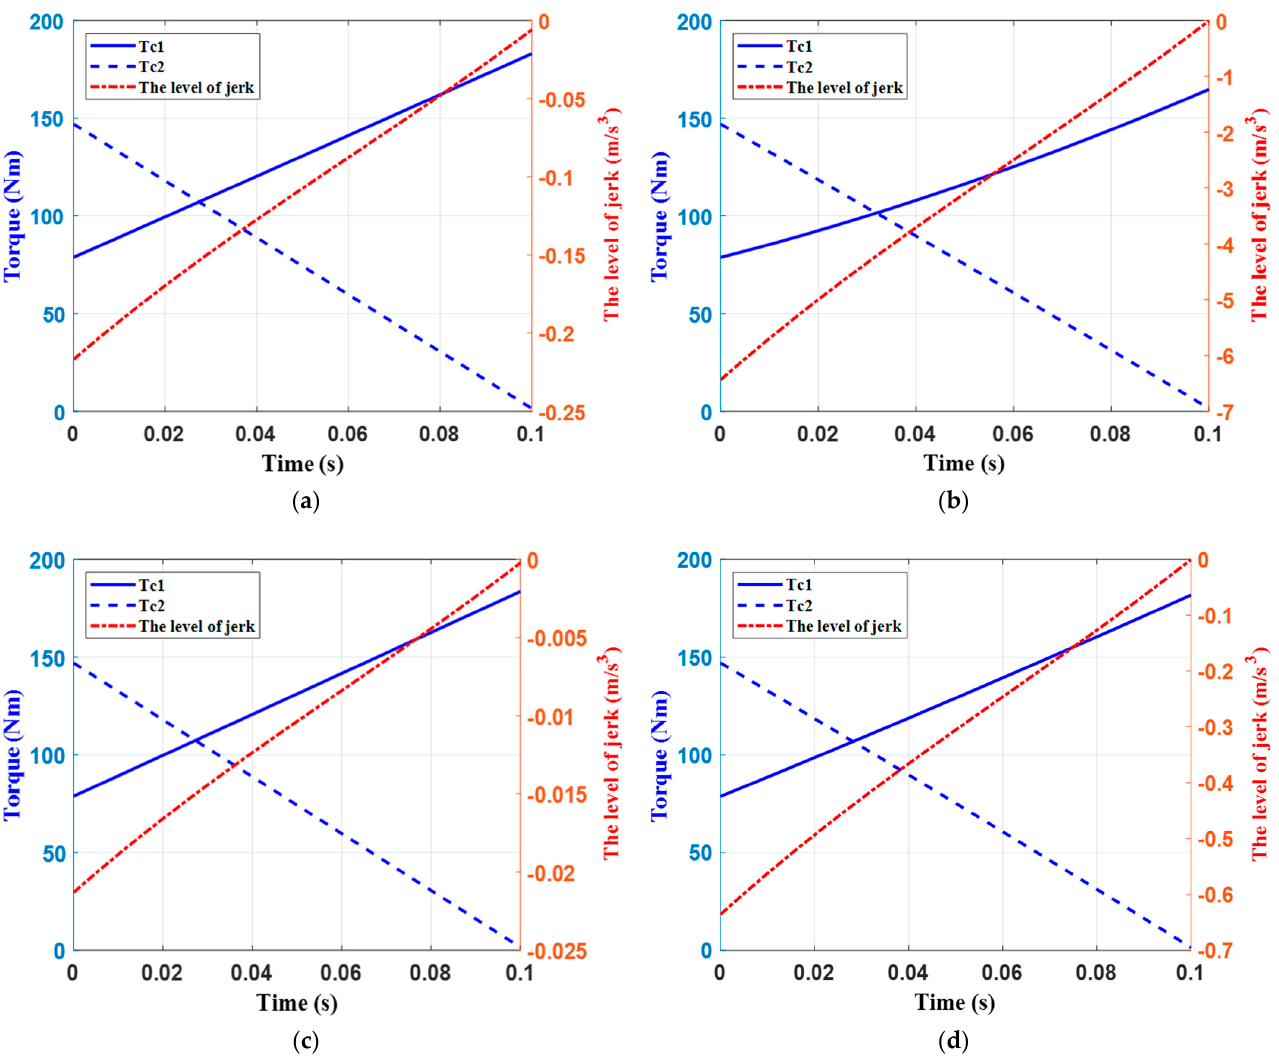
Figure 8. The influence of different values of the coefficient matrix on the control process with the opening of the throttle at 25%. ( a ) s = 0.05; Q = ( c ) s = 0.05; Q =